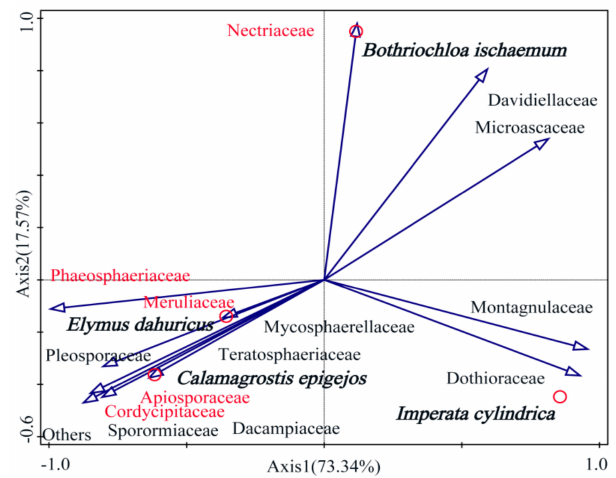
Figure 5. Principal Coordinate Analysis (PCoA) of four native grasses (shown in bold), at family level (the relative abundance greater than 0.001, and special families in each native grasses were shown in